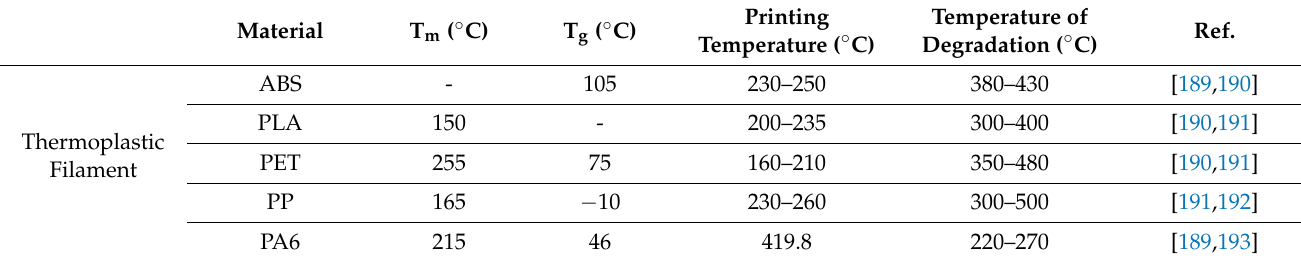
Table 3. Melting temperature and glass transition temperature of a few common thermoplastic filaments for FDM.